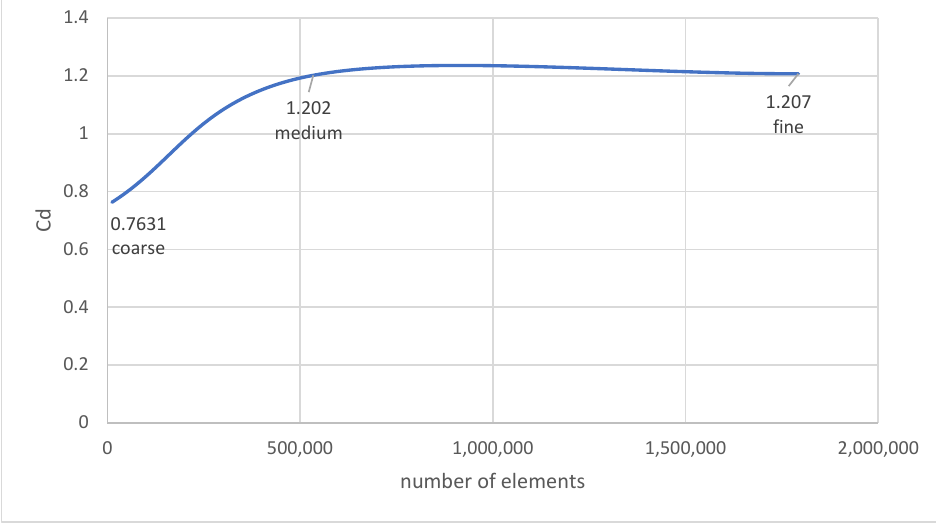
shows that as the mesh is refined, the drag force and drag coefficient values between meshes have a converging value. These converging values prove to mesh independence and provide the most efficient size elements for the rest of the meshes to be created in this study.